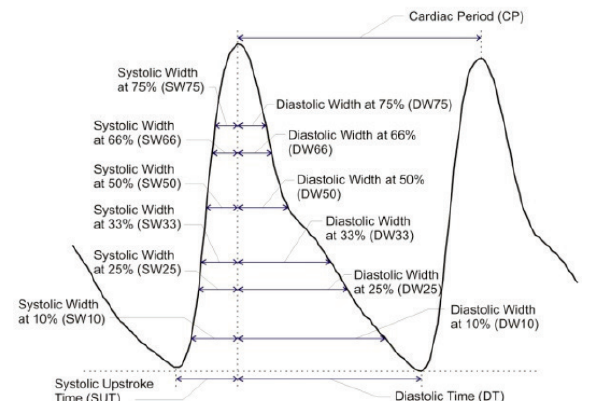
Figure 10. Sketch of systolic and diastolic widths at given pulse pressure level. Reprinted with permission from [6]. © 2013, IEEE.